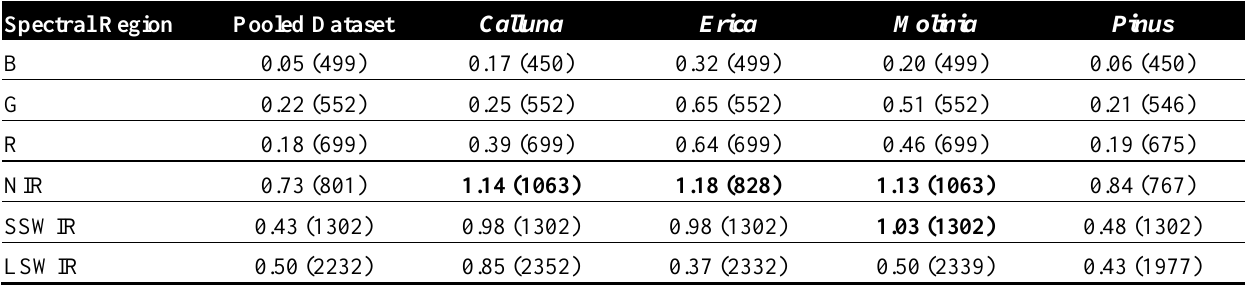
Table 4. Maximum separability index values to discern burned and unburned areas for each spectral region, both for pooled data and for each vegetation type separately. The corresponding Airborne Prism Experiment (APEX) bands (central wavelength in nm) are given between brackets. Values higher than one are given in bold. Spectral Region Pooled Dataset Calluna Erica Molinia